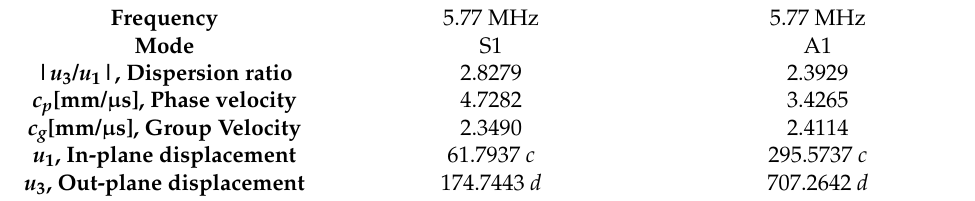
Table 2. Information for the two types of modes at 5.77 MHz.